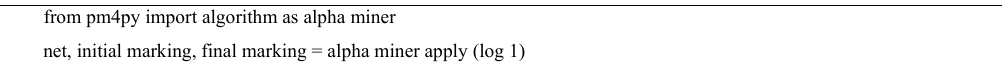
Algorithm 6. Conforming using